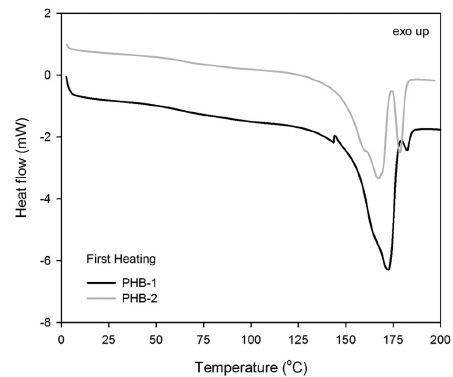
Figure 2. DSC scans of PHB-1 and PHB-2 during heating at 10